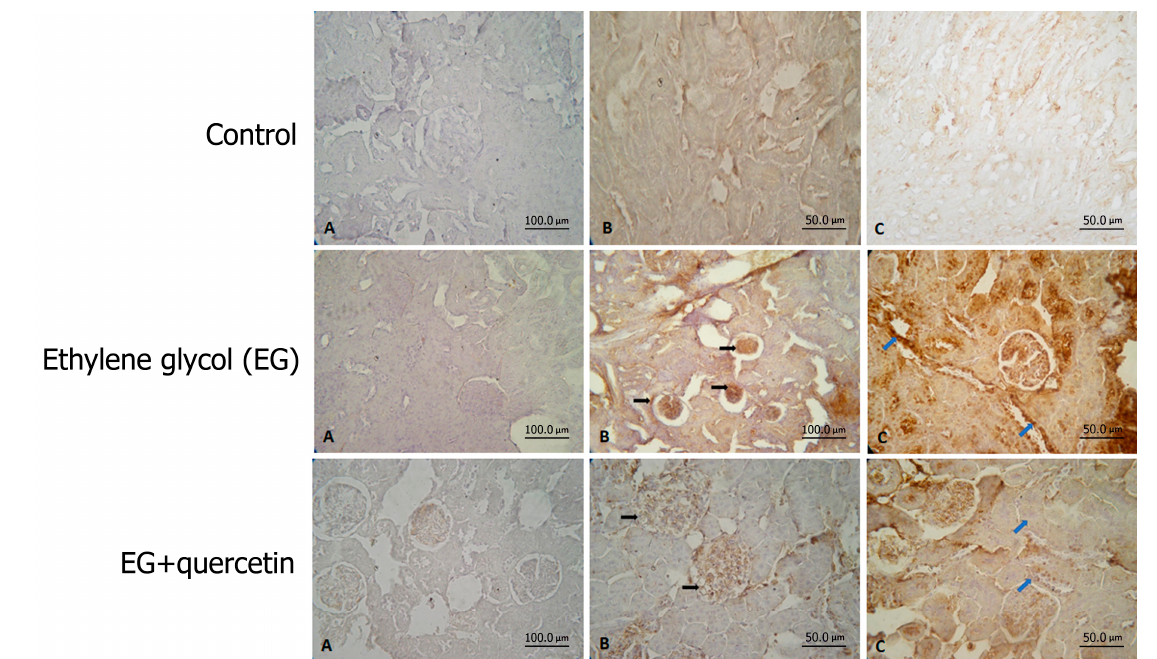
Figure 2. p38-MAPK and NF-kB stain of kidney tissue, and immunohistochemical assessment of all groups. Control: Samples with normal kidney tissue structure. Positive staining of p38-MAPK and NF-kB is not detected in the samples. Staining control (A), p38-MAPK (B) and NF-kB (C). Ethylene glycol (EG): Significant positive staining of p38-MAPK and NF-kB is detected in the samples compared to the control group. Staining control (A), p38-MAPK (B) and NF-kB (C). EG + quercetin: Decreased positive staining of p38-MAPK and NF-kB is detected in the samples compared to the ethylene glycol group. Staining control (A), p38-MAPK (B) and NF-kB (C). Table 2. Statistical data between groups in terms of p38-MAPK and NF-kB (Mann-Whitney test).